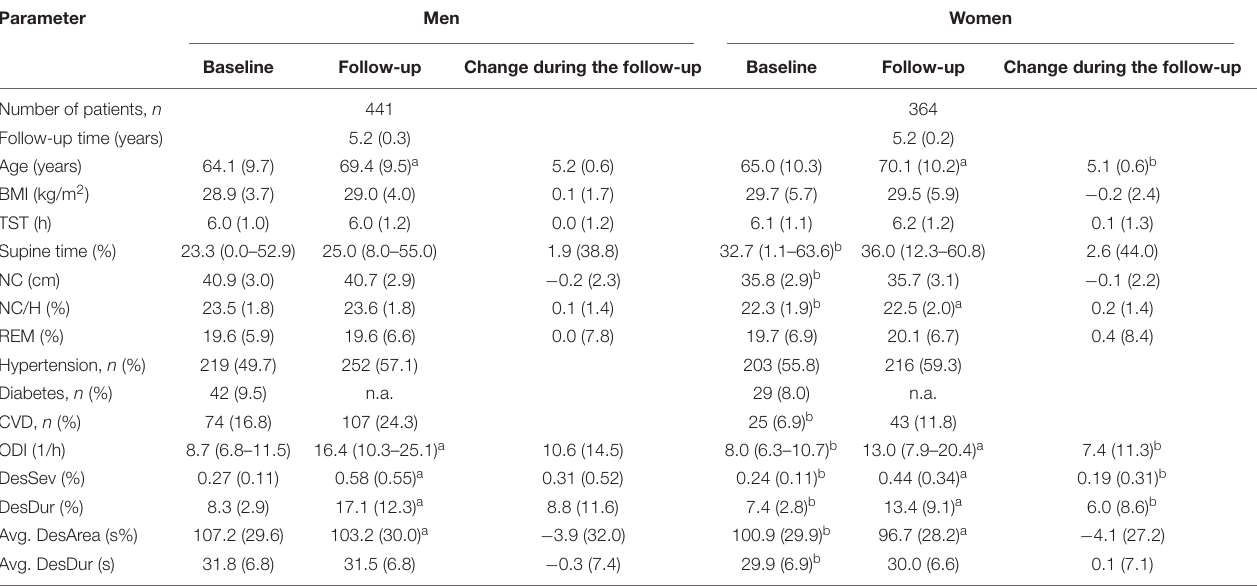
TABLE 2 | Demographic, anthropometric, and desaturation parameter values for men and women participants with mild sleep apnea at baseline and after a mean follow-up time of 5.2 years. Parameter Men Women Baseline Follow-up Change during the follow-up Baseline Follow-up Change during the follow-up Number of patients, n 441